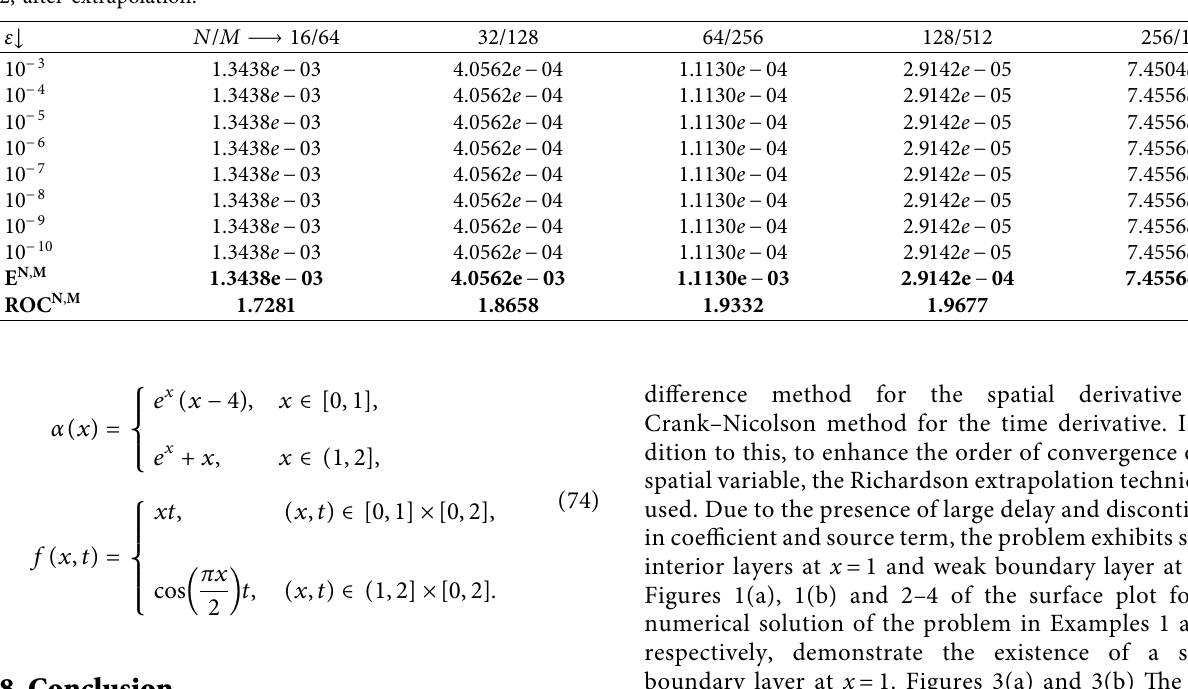
Table 4: Computed maximum point-wise errors, ε -uniform errors ( E N,M ) , and the ε − uniform rate of convergence ( ROC N,M ) for Example 2, after